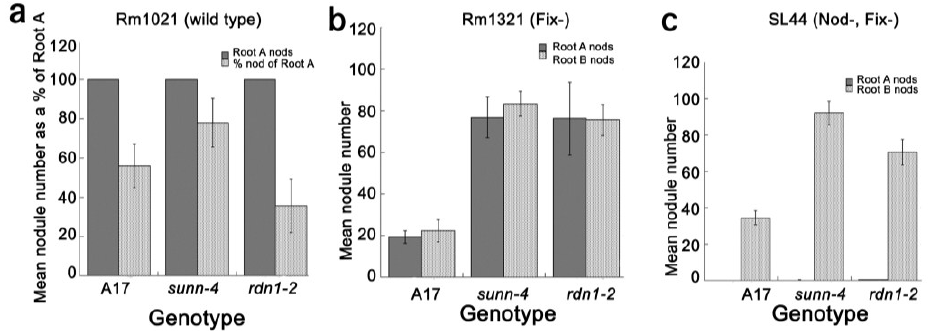
( b ) Rm 1312 (Nod + /Fix − ), and ( c ) SL44 (Nod − /Fix − ). Error bars for ( b ) and ( c ) are standard error of the mean ( n = 5 to 10 plants per genotype per